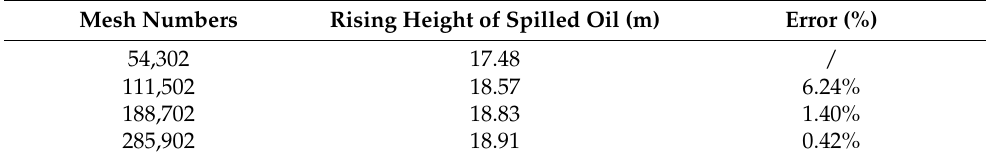
Table 1. Sensitivity of grid size to simulation results.